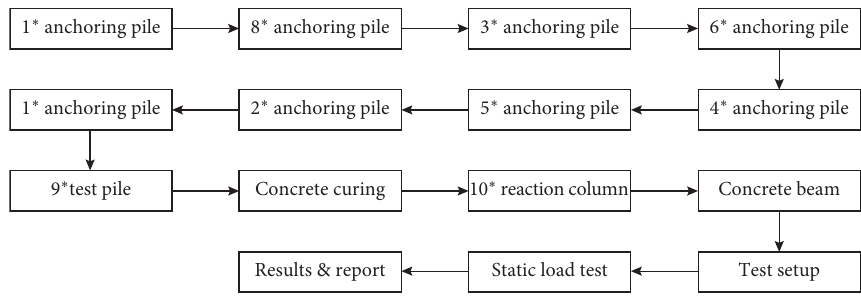
Figure 4: Construction process. Table 1: Information of the test process.